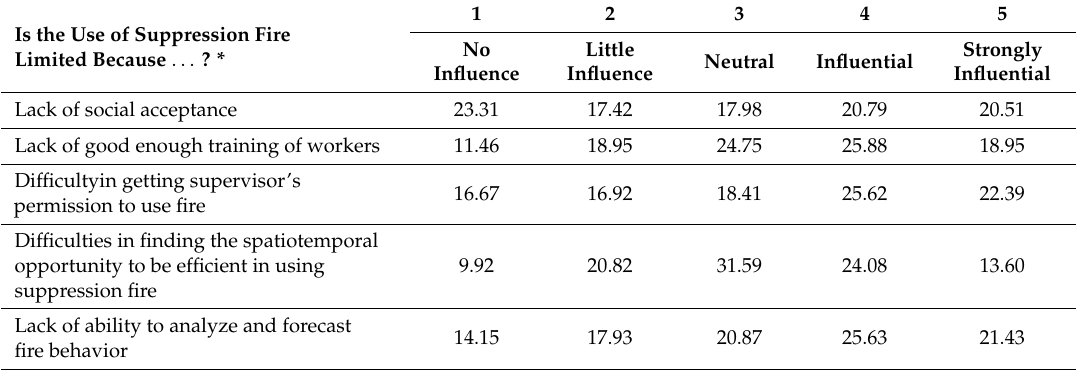
Table 4. Responses identifying which factors are perceived as limiting the use of fire in suppression. Data displays perception of respondents (percentages of total, N = 726) who chose the degree of influence of each